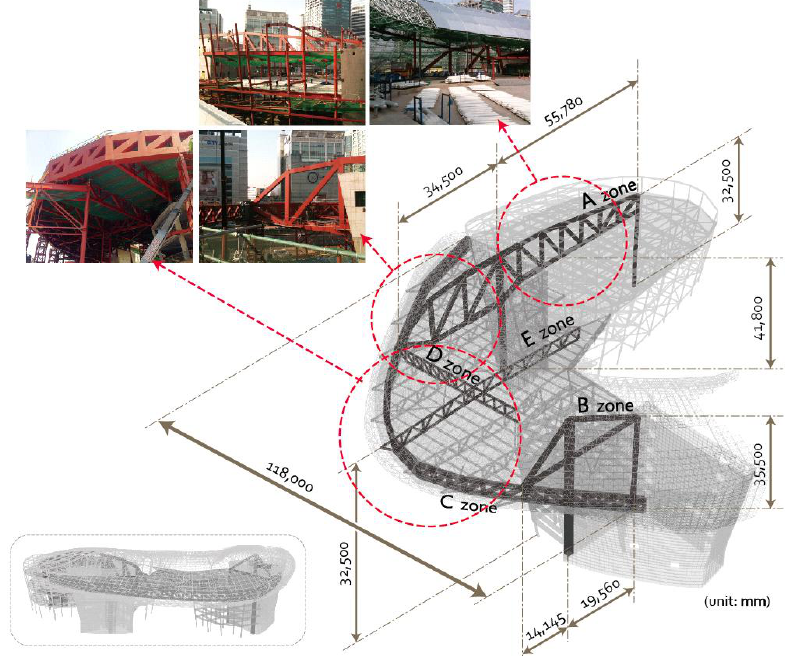
Figure 7. Structure zoning of SHM on the irregular shaped building at